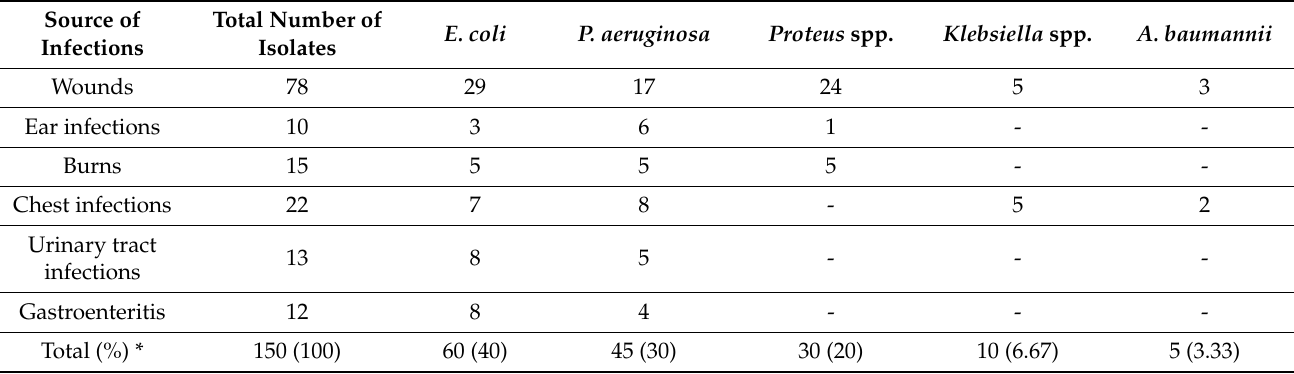
Table 1. Prevalence of isolated bacteria among different infections.